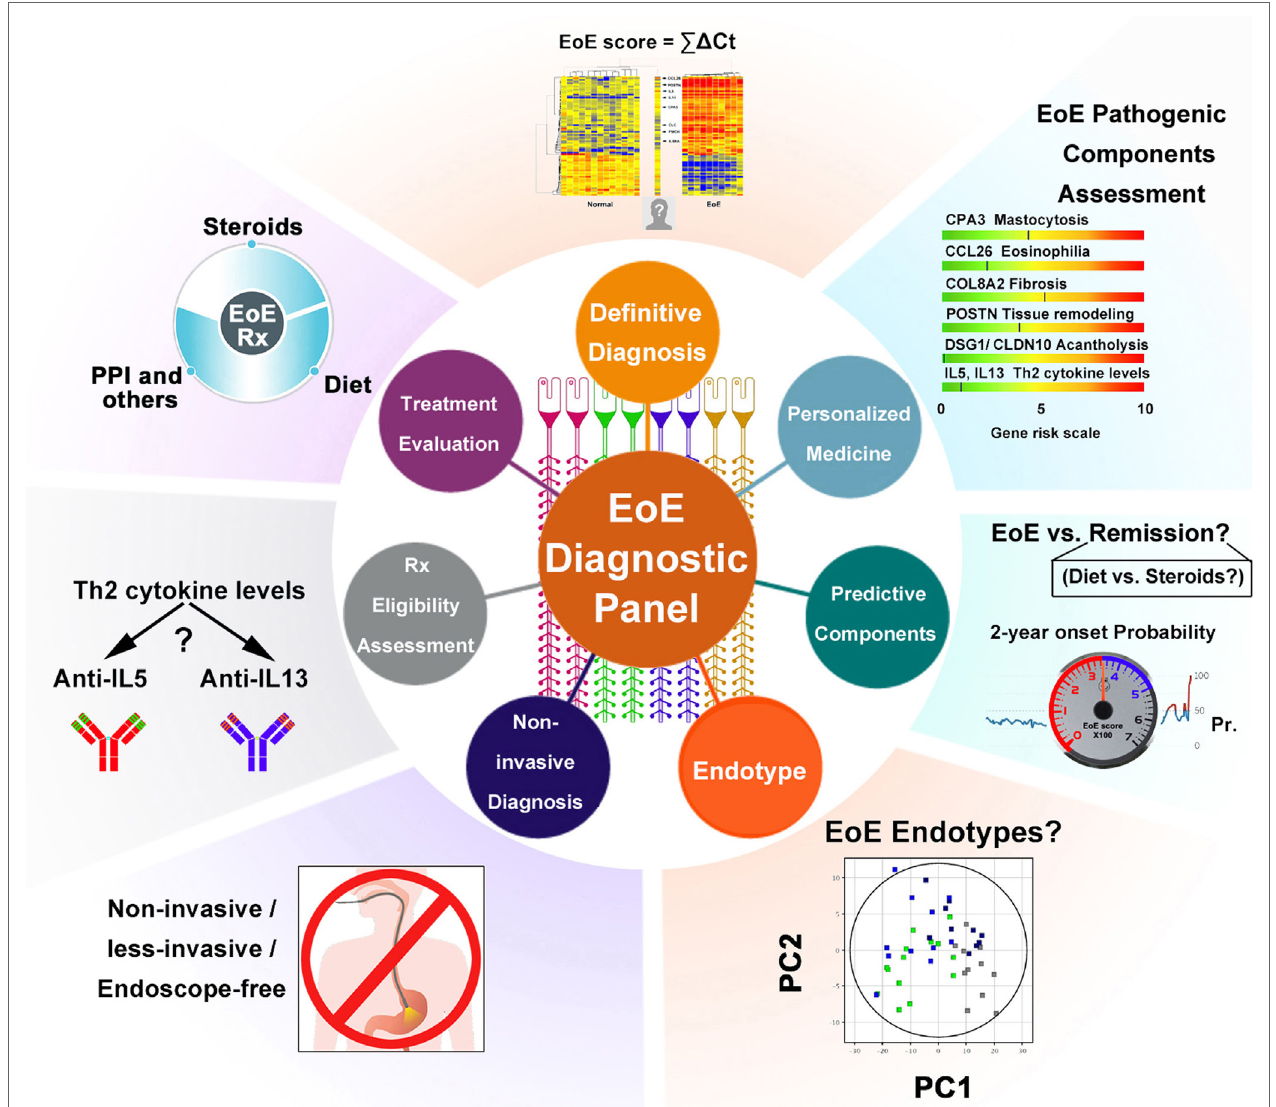
FiguRe 1 | Schematic summary of the EDP’s multiple functions. Multiple components of the EDP are graphically summarized to illustrate the applicable functions of the molecular panel. Some are in clinical practice, whereas others are potentials for future diagnostic utilities. Abbreviations: PPI, proton pump inhibitor; Th2, T helper type 2; Rx, treatment; EoE, eosinophilic esophagitis; PC, principal component; ΣΔ CT, EoE score = Σ (Ct. downregulated gene − Ct. GAPDH) − Σ (Ct. upregulated gene − Ct. GAPDH) (refer to Wen et al. study); Pr., probability; 2-year onset probability, the estimated possibility of EoE relapse for patients who currently have EoE in